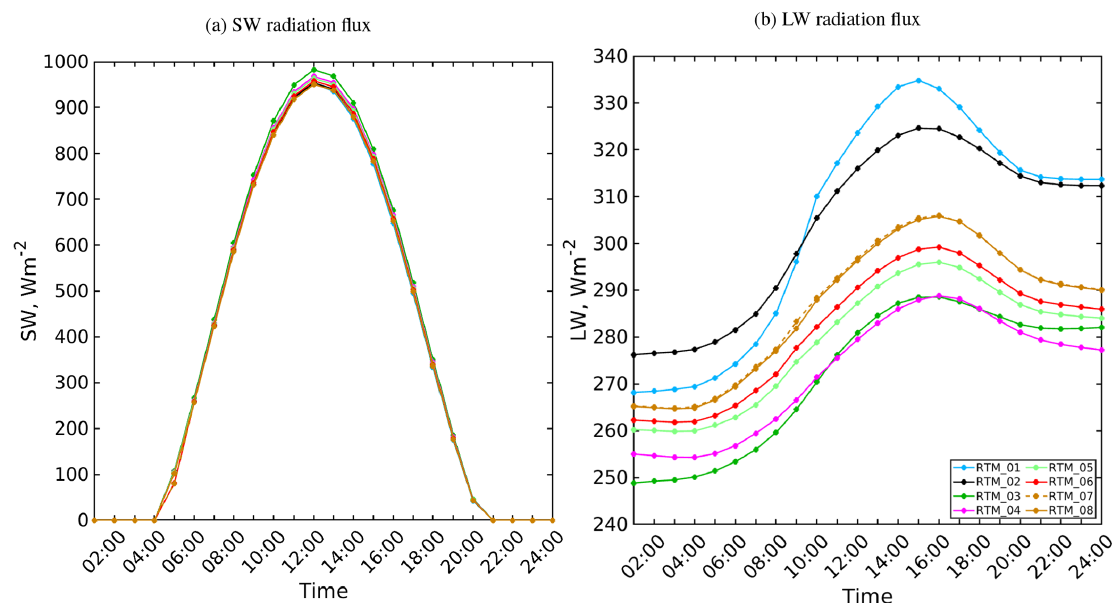
Figure 16. The daily course of (a) incoming shortwave and (b) incoming longwave radiation fluxes for the top of urban layer of the realistic urban configuration at 52 ◦ N on 1 July.